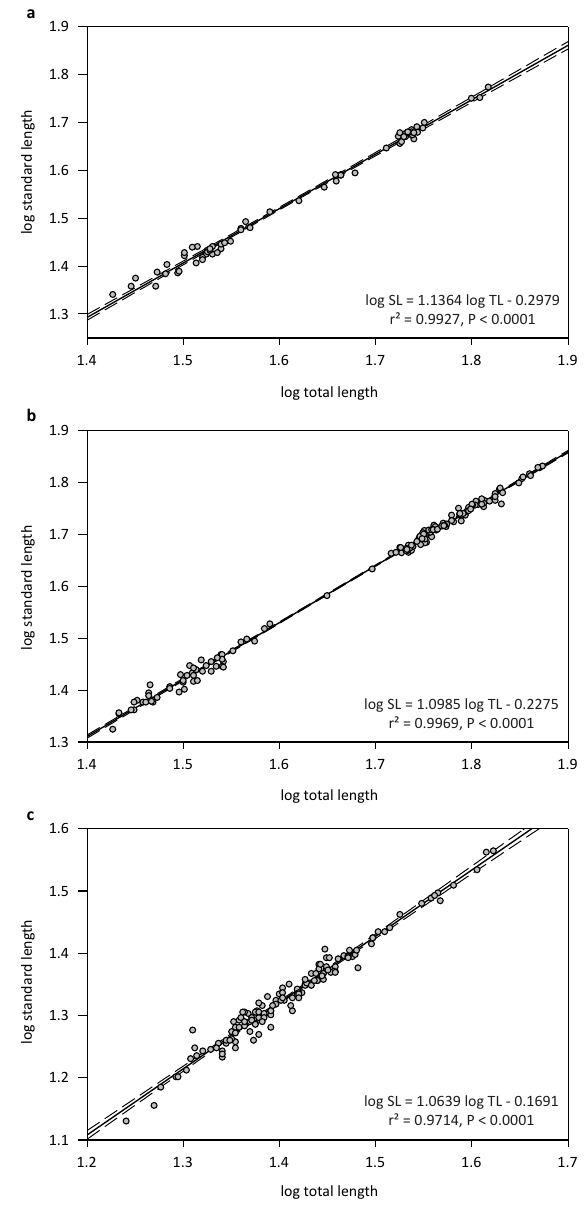
Figure 3. Length-length relationship of (a) Channa diplogramma , (b) Channa marulius and (c) Channa striata . Dashed lines indicate 95% confidence interval for the regression